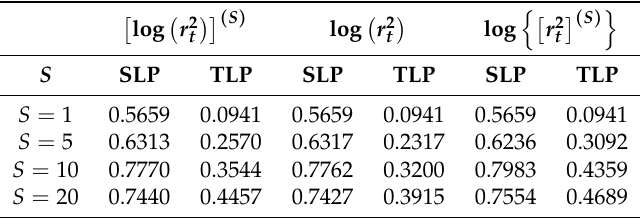
Table 1. Long-memory parameter estimates with daily S&P 500